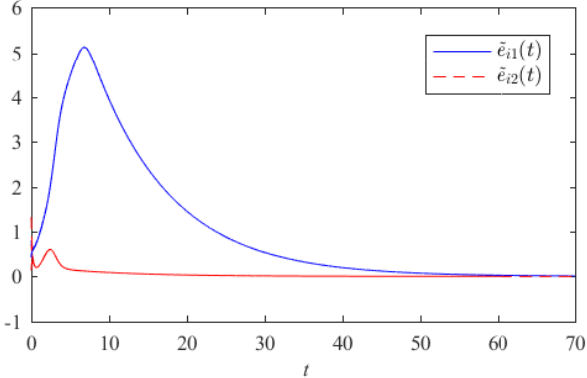
Figure 5. ˜ e i ( t ) with the control gains d = 2.1 and k = 0.1 in Example